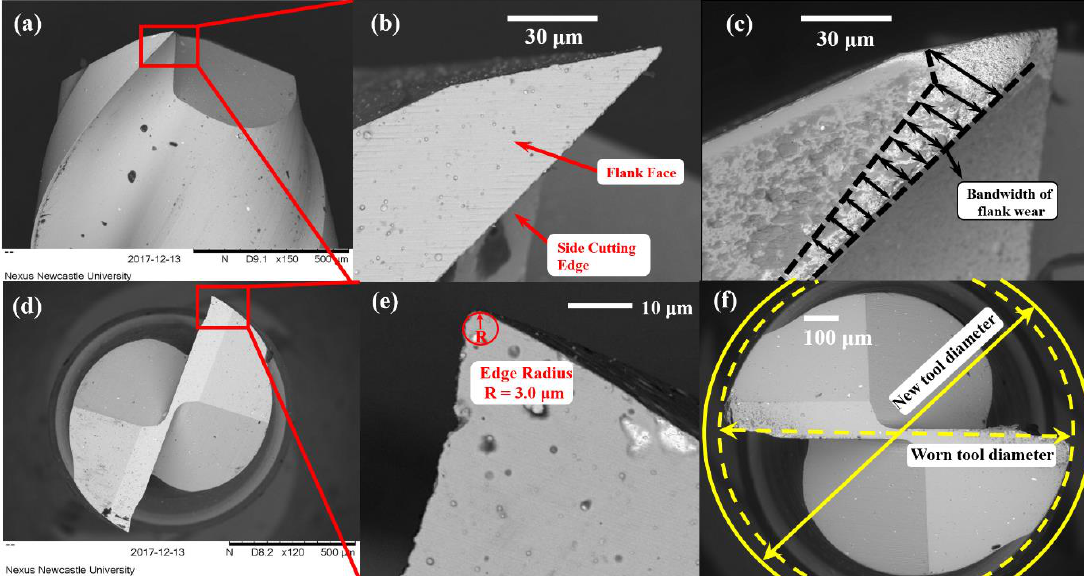
Figure 6. SEM results of cutting tools. ( a ) A side view of a brand new tool; ( b ) the flank face of the brand new tool; ( c ) the measurement method of the tool flank wear; ( d ) a top view of brand new tool; ( e ) the measurement method of the tool edge radius; ( f ) the measurement method of the worn tool diameter loss.